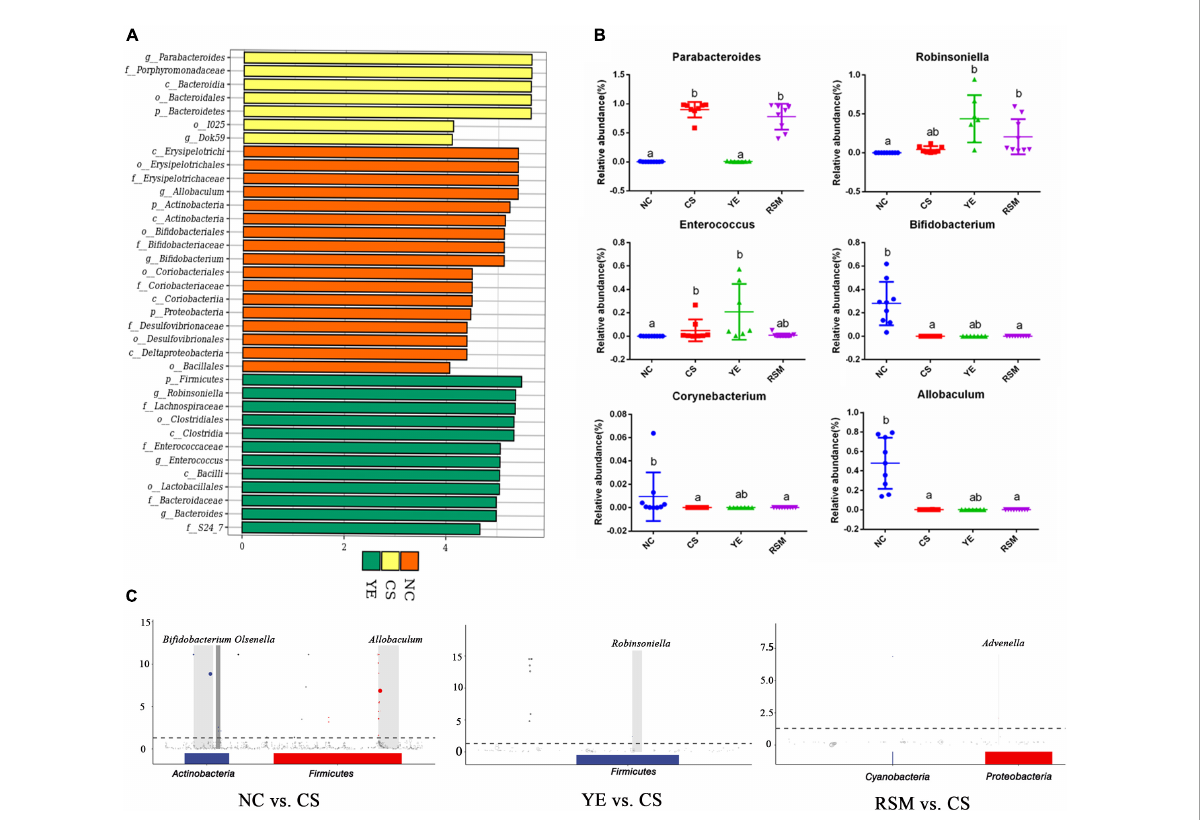
FIGURE5 Effects of two kinds of algal oil on gut microbiota profile. (A) Histogram of the LDA value and clade distribution for the differential microbial community in each group. (B) The relative abundance of representative bacteria at genus level. (C) ASV/OTU Manhattan chart based on metagenomeSeq differences. Data ( n = 9 per group) are expressed as mean ± SEM; groups with different letters statistically differ. Groups with the same letter are considered to have no significant differences, groups with different letters are significantly different from each other ( P <